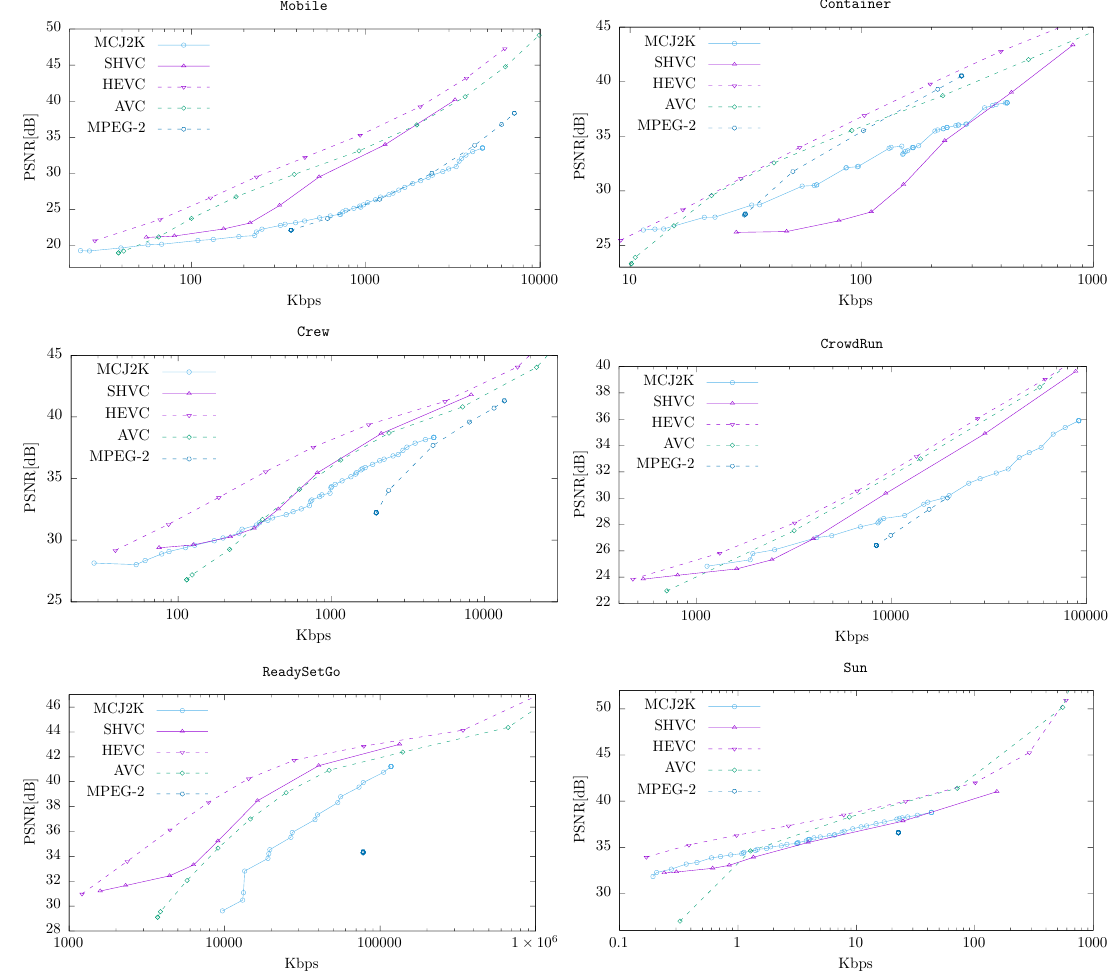
Figure 7. MCJ2K (using ESLA) vs. other codecs for different